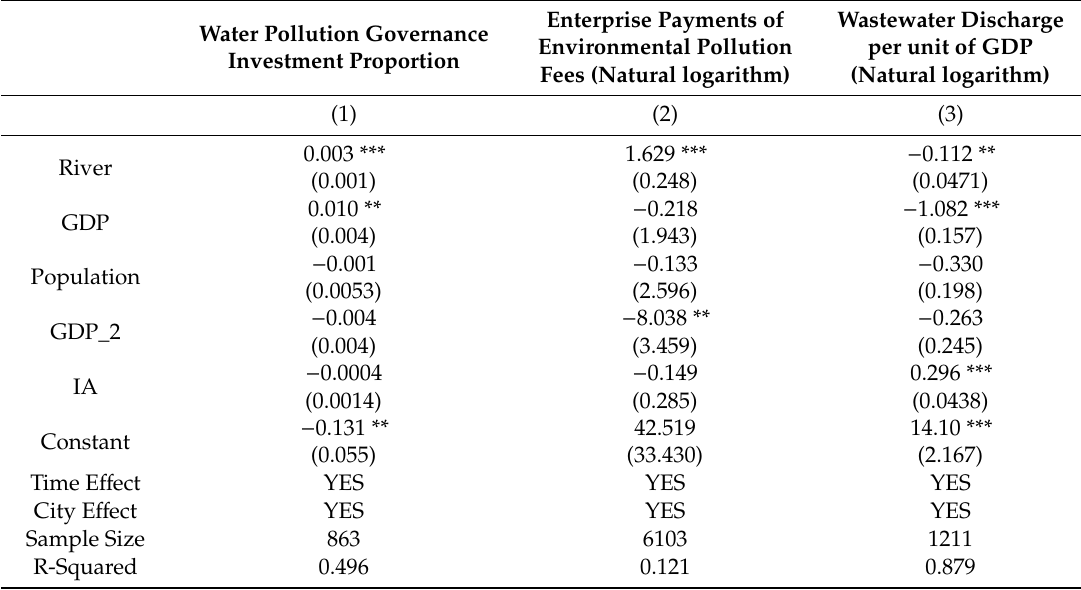
Table 3. E ff ects of the River Chief System (RCS) on water